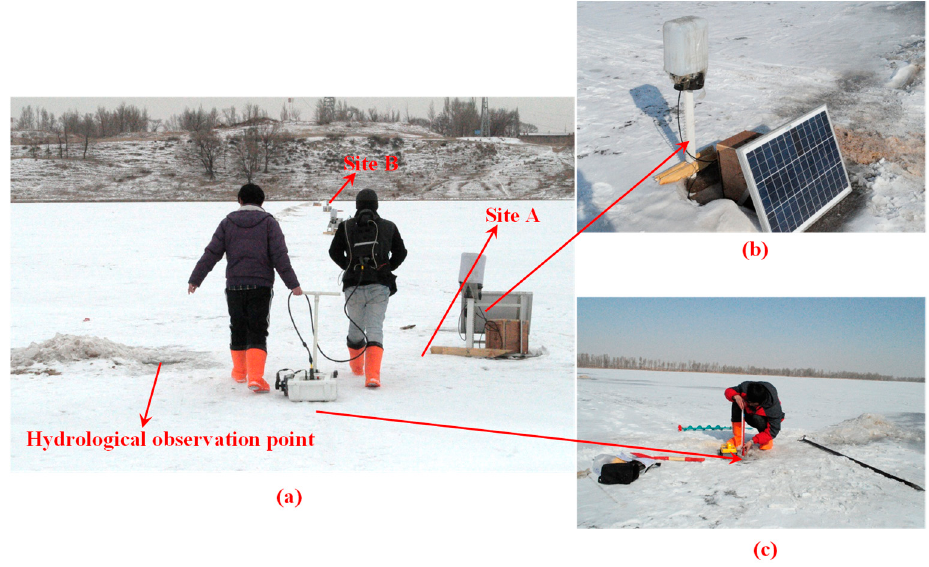
Figure 3. Pictures of the test site. ( a ) GPR survey. ( b ) Temperature measuring device. ( c ) Measurement of ice thickness using drilling method.